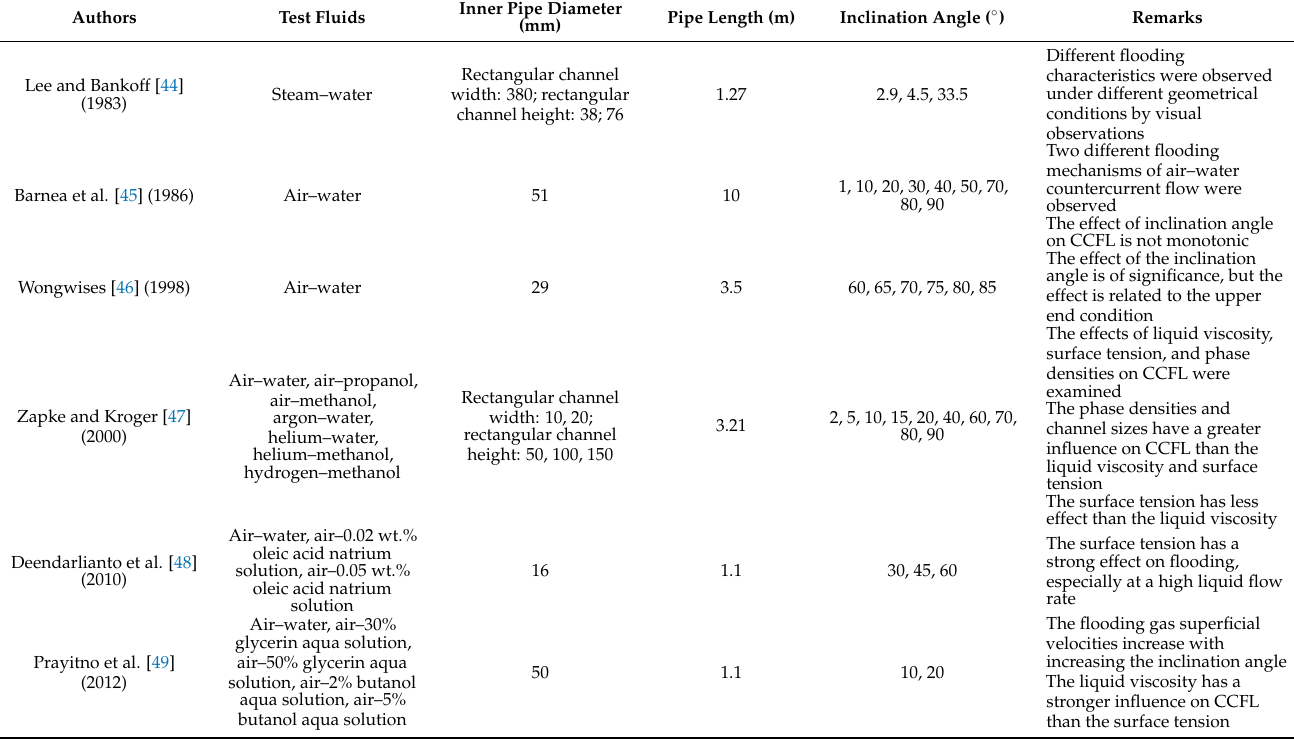
Table 3. Summary of the experimental investigations on the CCFL in inclined